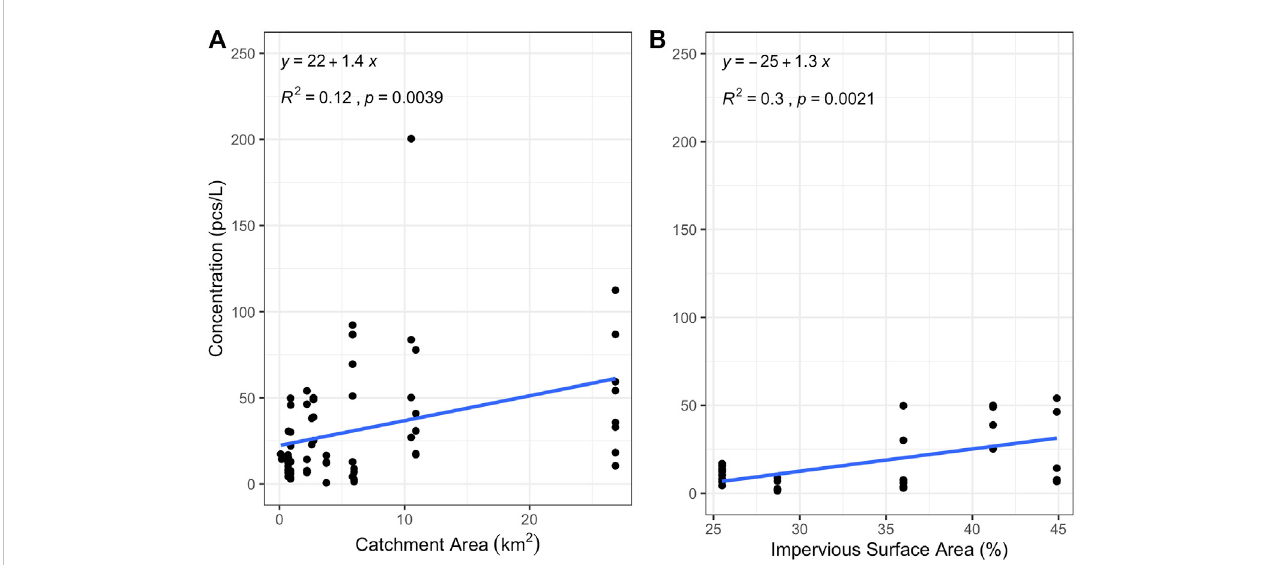
FIGURE 5 Linear regression between (A) microplastic concentrations and total catchment area for all samples and (B) the total concentration of microplastics in stormwater from a subset of fi ve outfalls and the percent impervious surface area within the catchment.